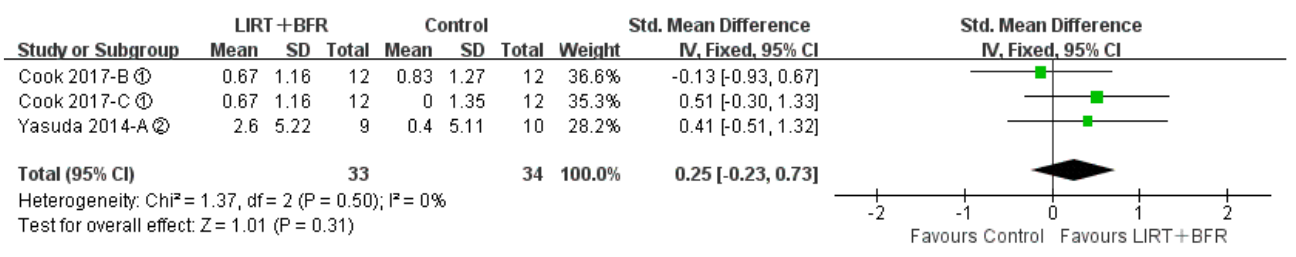
Figure 5. Meta-analysis of lower limb muscle function [17,23]. Figure Notes: A, LIRT + BFR VS Daily exercise; B, LIRT + BFR VS LIRT; C, LIRT + BFR VS HIRT. ① SPPB; ② 30 s sit to stand test(s).